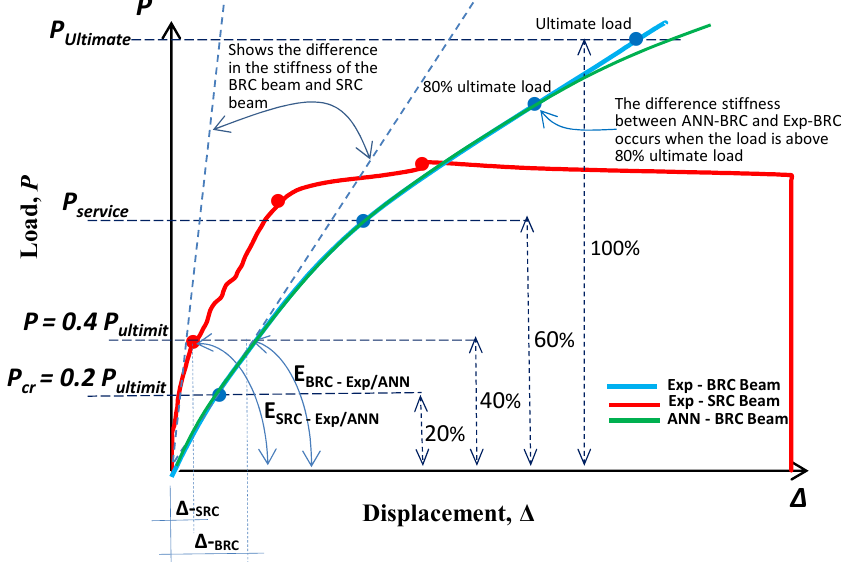
Figure 16. The difference in stiffness between the SRC beam, BRC beam, and BRC beam of ANN Figure 16. The di ff erence in sti ff ness between the SRC beam, BRC beam, and BRC beam of ANN analysis result. analysis